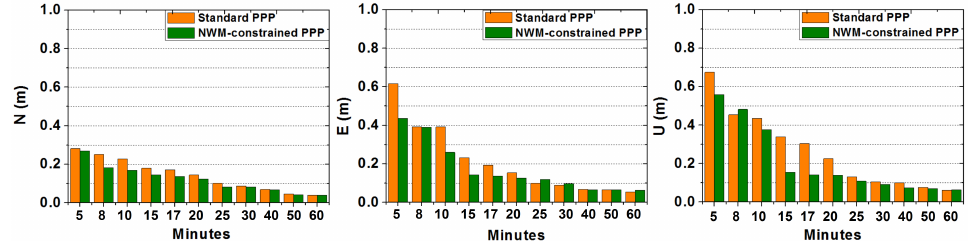
Figure 8. The rms values for the north, east, and vertical components with multi-GNSS PPP solution, shown at different session lengths (5, 8, 10, 15, 17, 20, 25, 30, 40, 50, and 60min) for all 21 four-system stations of the MGEX network from 1 to 30 September 2015. The standard PPP solution is shown in orange, the NWM-constrained PPP solution in